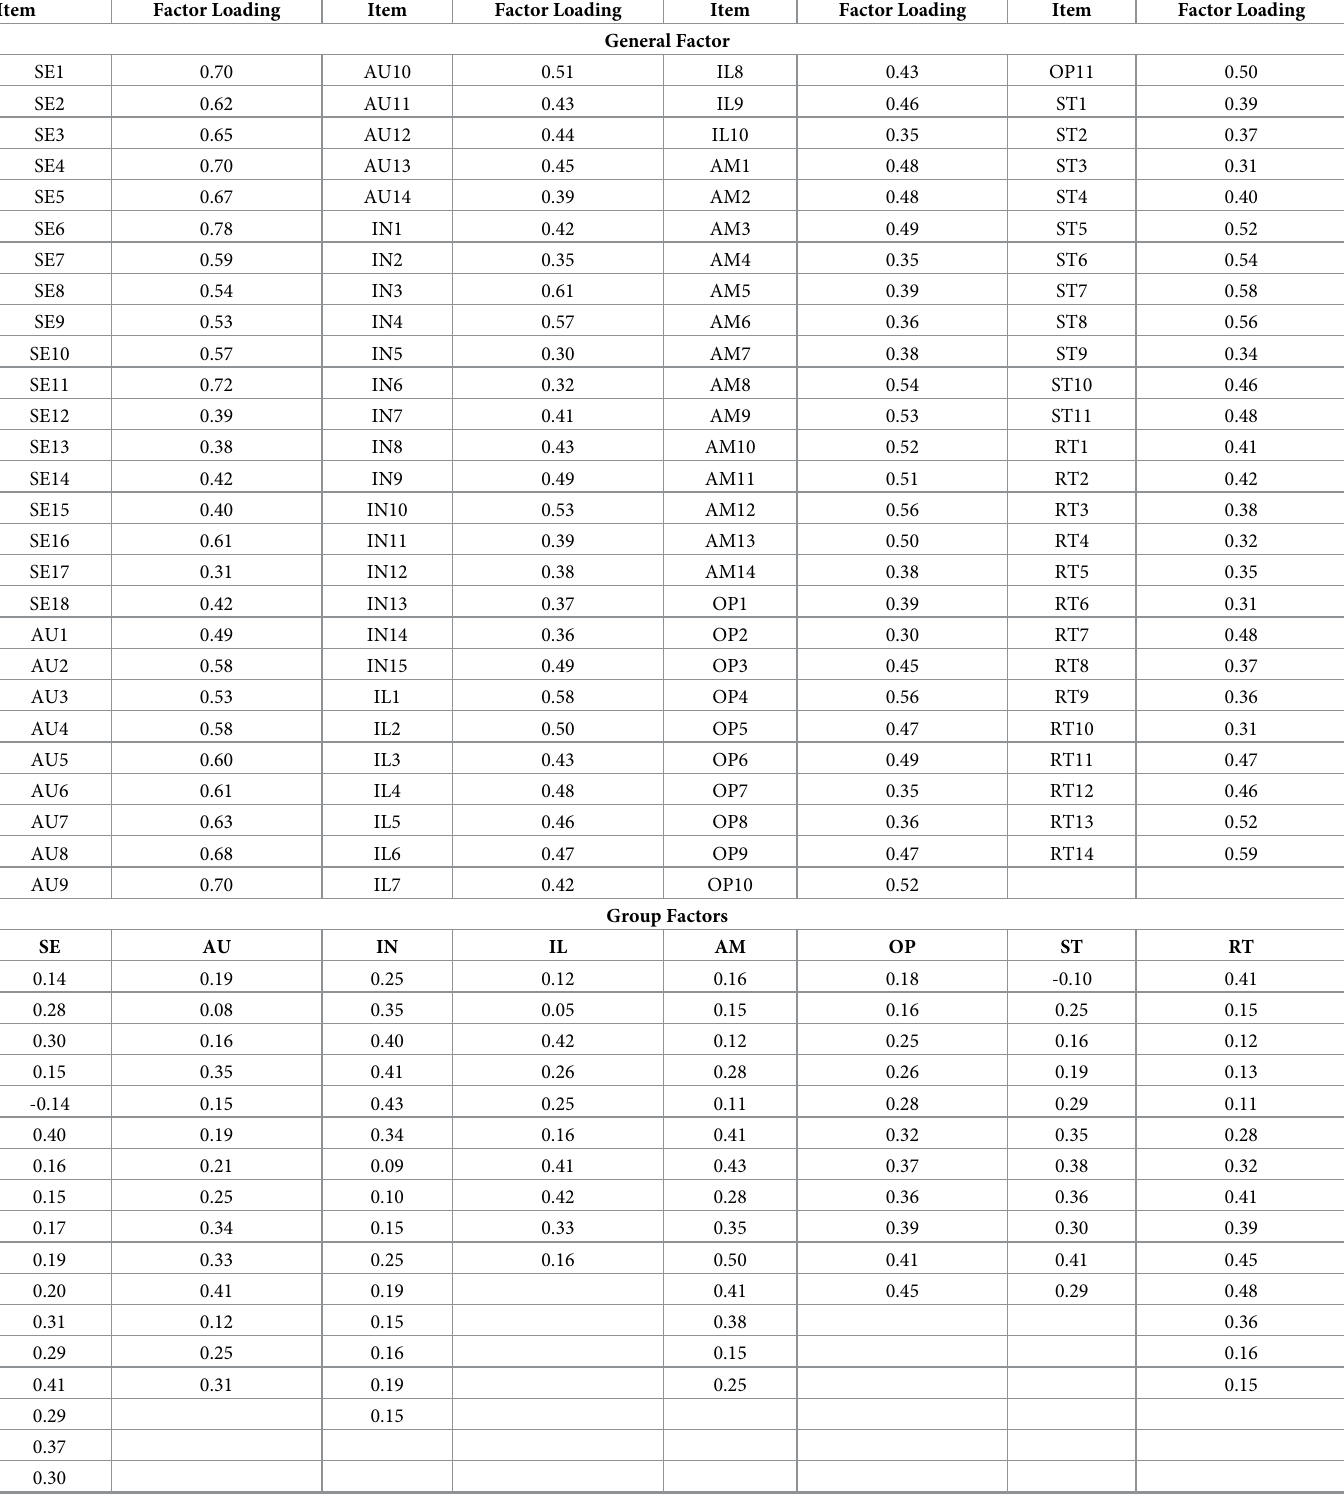
Table 2. Factor loadings of the general factor and the specific factors of the bifactor